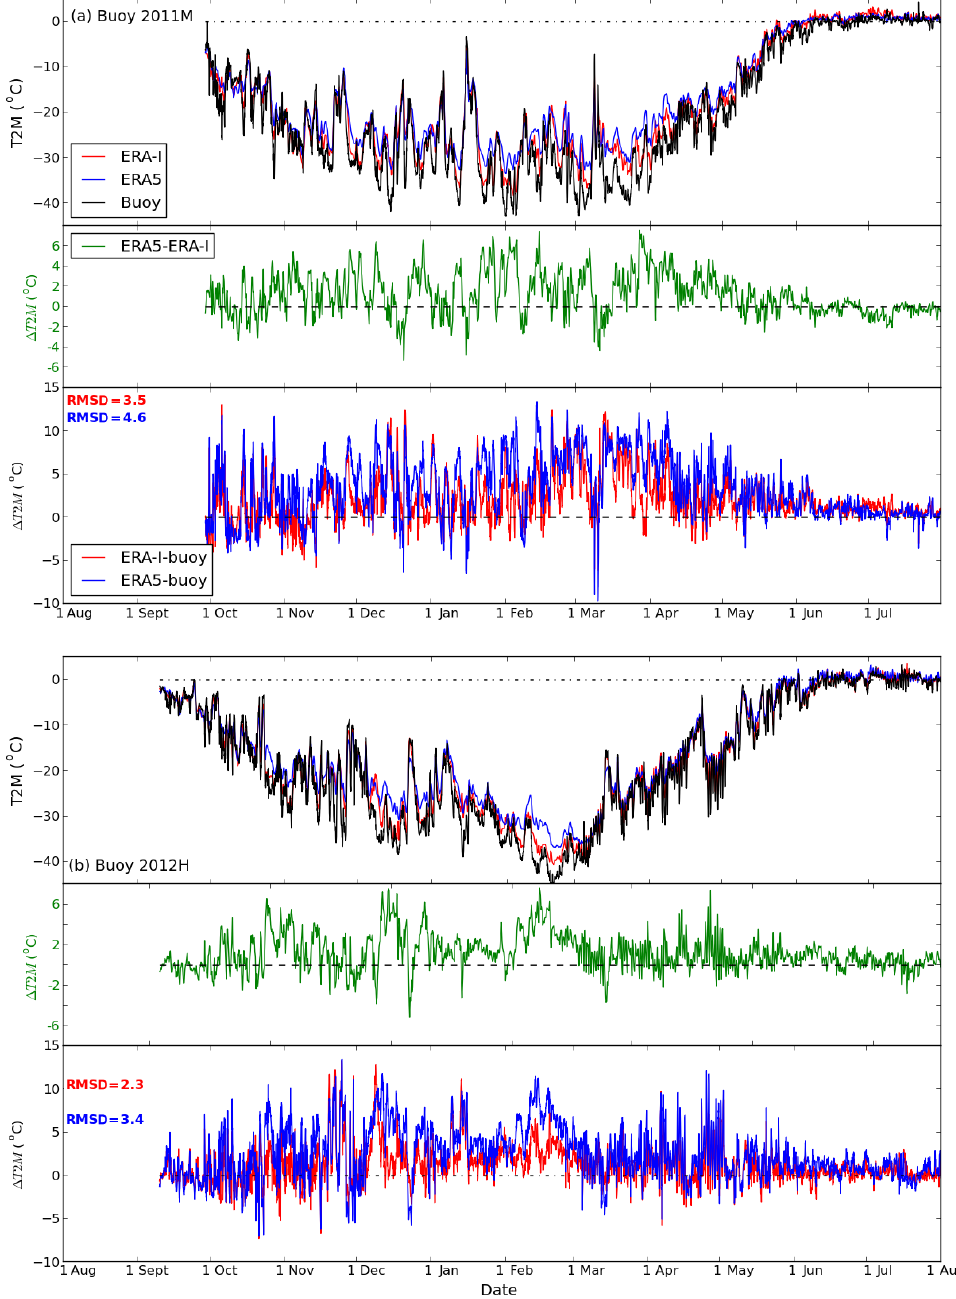
Figure 4. Same as Fig. 3, but for (a) buoy 2011M and (b) buoy 2012H.